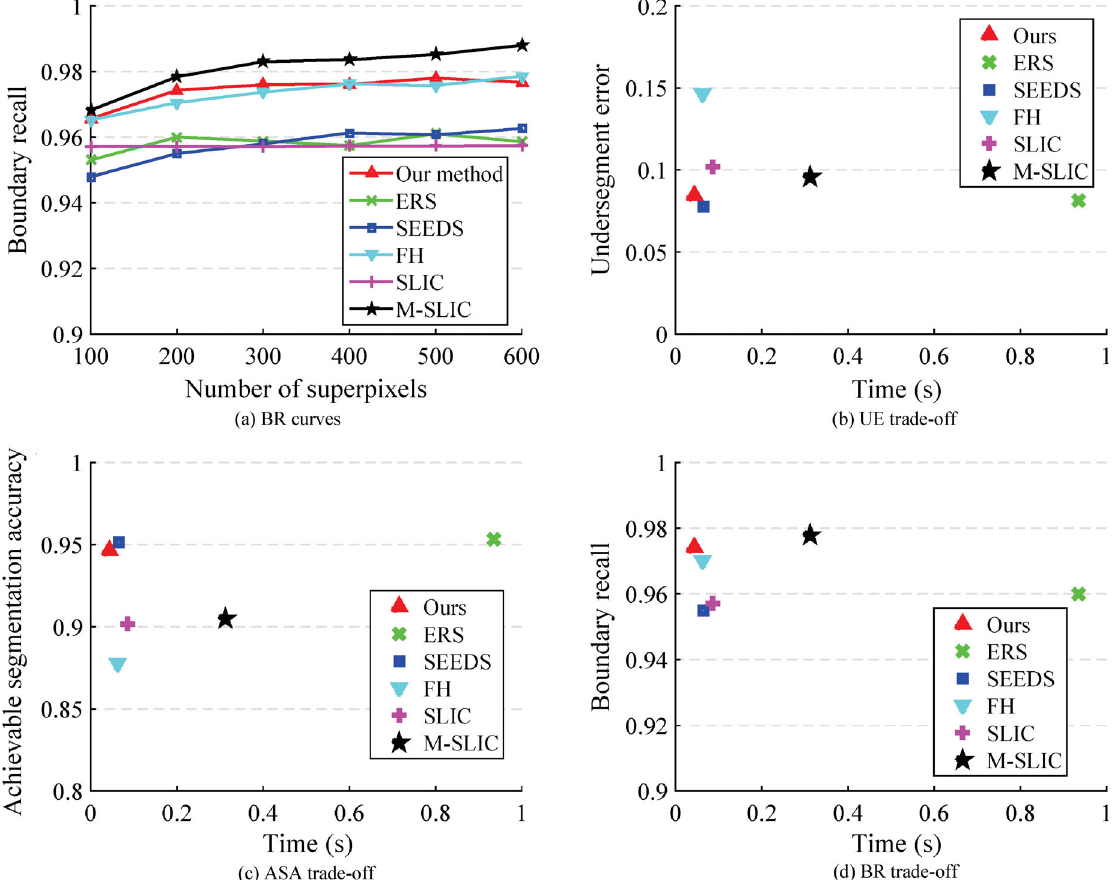
Fig. 7 Comparisons between state-of-the-art methods and our approach on the Pascal Context dataset. Due to the simplicity of this dataset, almost all over-segmentation methods yield good boundary recall. The proposed method achieves a competitive trade-off on this